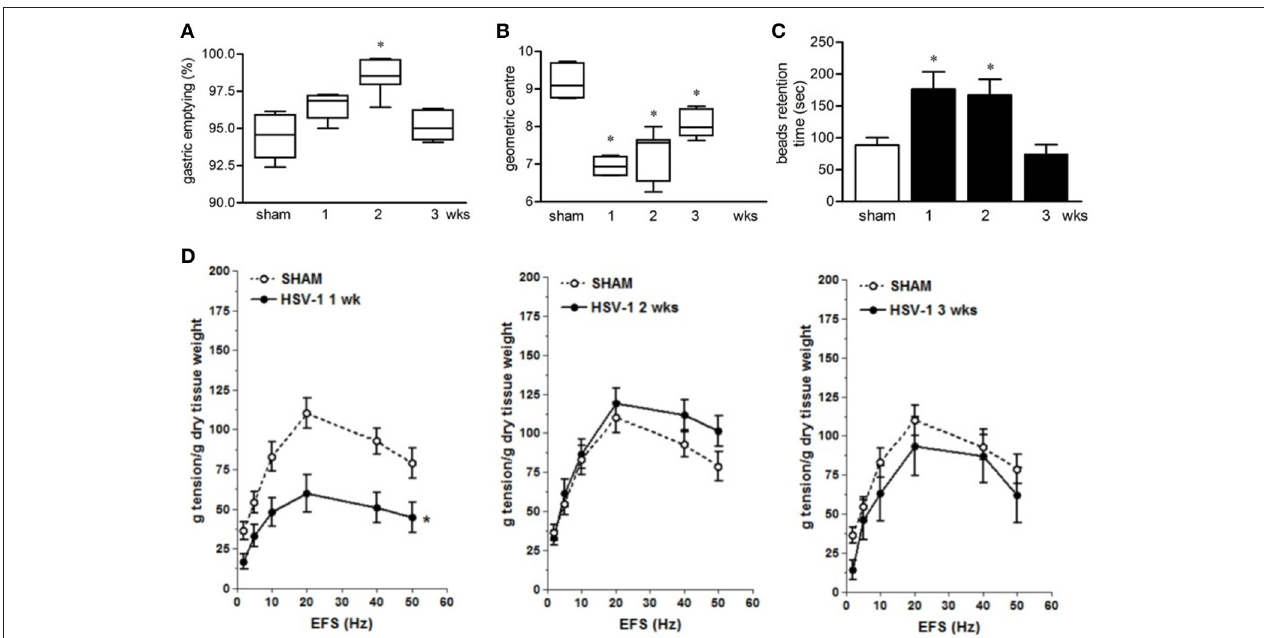
FIGURE 2 | Gastrointestinal dysmotility in HSV-1 infected mice. (A) One, two, and three weeks post-IG infection with replicating HSV-1 strain SC16, mice were injected with non-absorbable FITC-labeled dextran. Sixty minutes later mice were sacrificed. Gastric emptying was calculated as the percentage of probe retained into the stomach compared with the total amount of fluorescence in the gastrointestinal tract. (B) Distribution of FITC-labeled dextran was determined in the intestine. Intestinal transit was reported as the geometric center of distribution of the fluorescent probe throughout the ileum. (C) Time (seconds, sec) required for expulsion of a glass bead inserted into the rectum. (D) Electrical field stimulation (EFS)-elicited contractions in segments of ileum from sham and IG HSV-1 infected mice. Data are represented as mean ± SEM. n = 6–12 mice per group. *Denotes P < 0.01 compared to sham infected